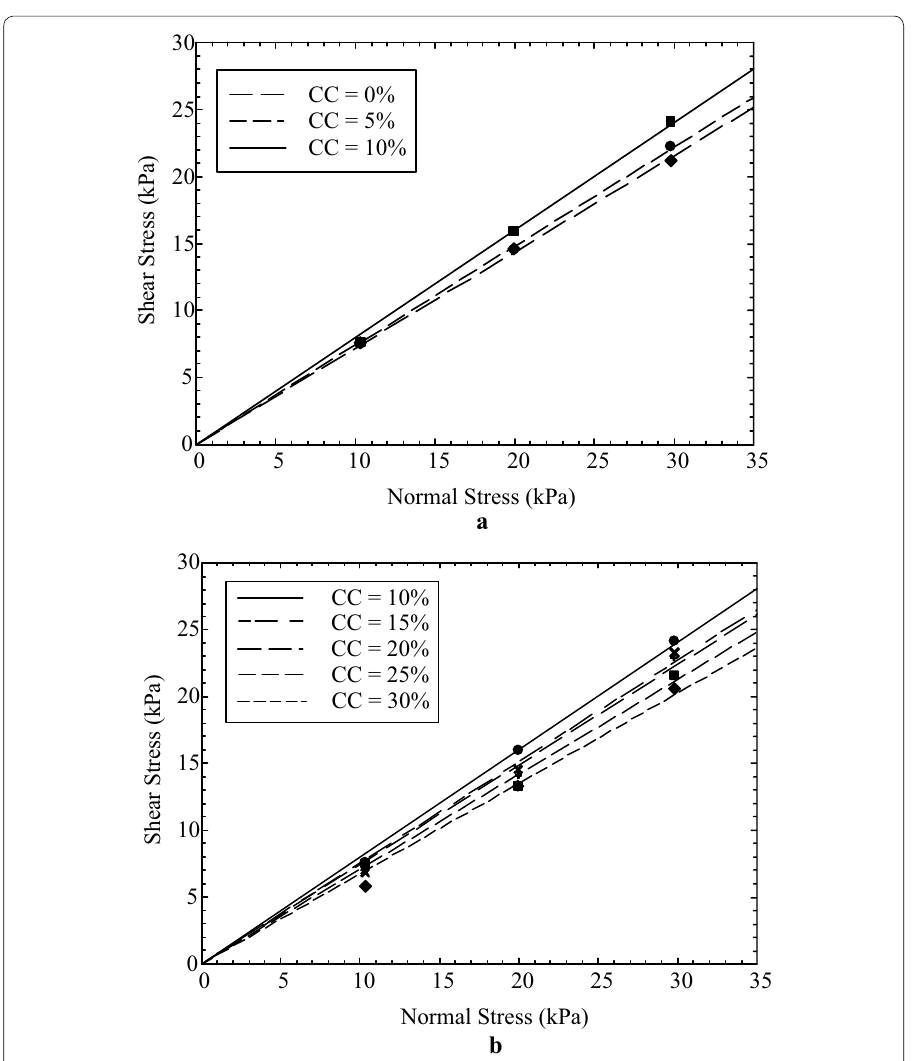
Fig. 7 Failure envelopes of clay–sand mixtures from direct shear tests for clay content ranges of a 0–10%, and b